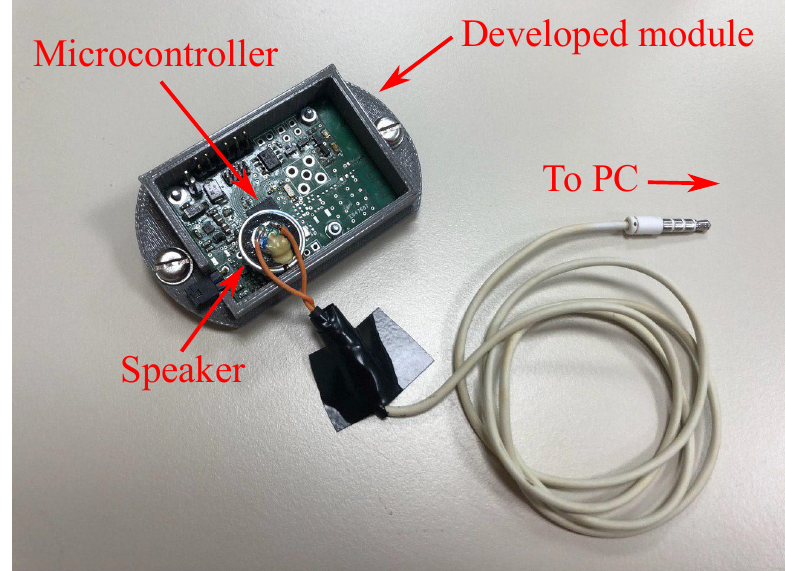
Test setup including the developed module and the speaker that reproduces the synthesized